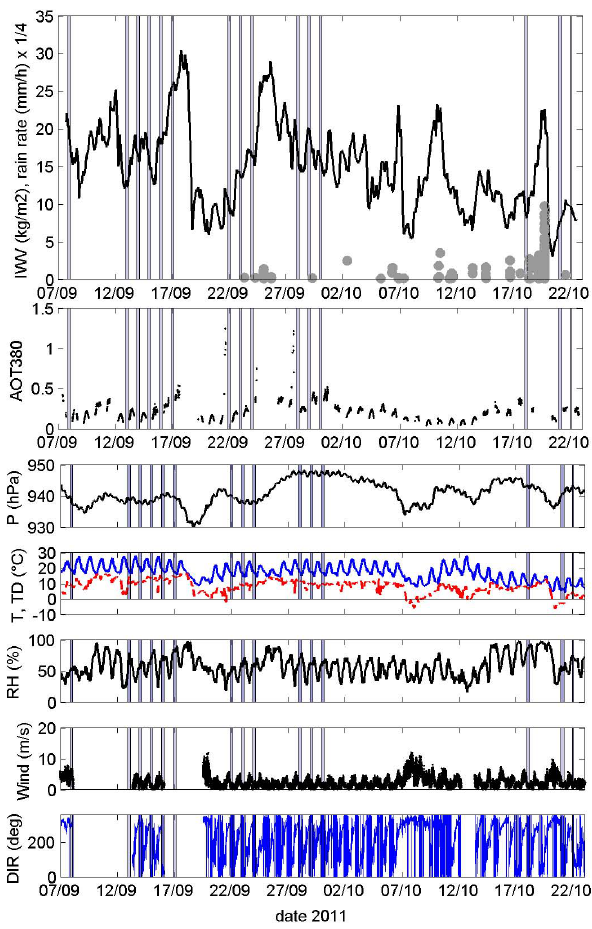
Fig. 2. Time series of atmospheric parameters measured during the DEMEVAP 2011 campaign. From top to bottom: IWV from GPS No.1 (black line) superimposed with rain rate (grey dots) from auto- matic weather station (AWS) of OHP (only data > 0.5mmh − 1 are plotted; maximum is 39mmh − 1 ); aerosol optical thickness (AOT) at 380 nm measured by AERONET sun photometer; P , T , TD and RH from PTU1 station on 10-mast; Wind speed and direction from AWS of OHP. The vertical bars denote the night-time lidar observ- ing